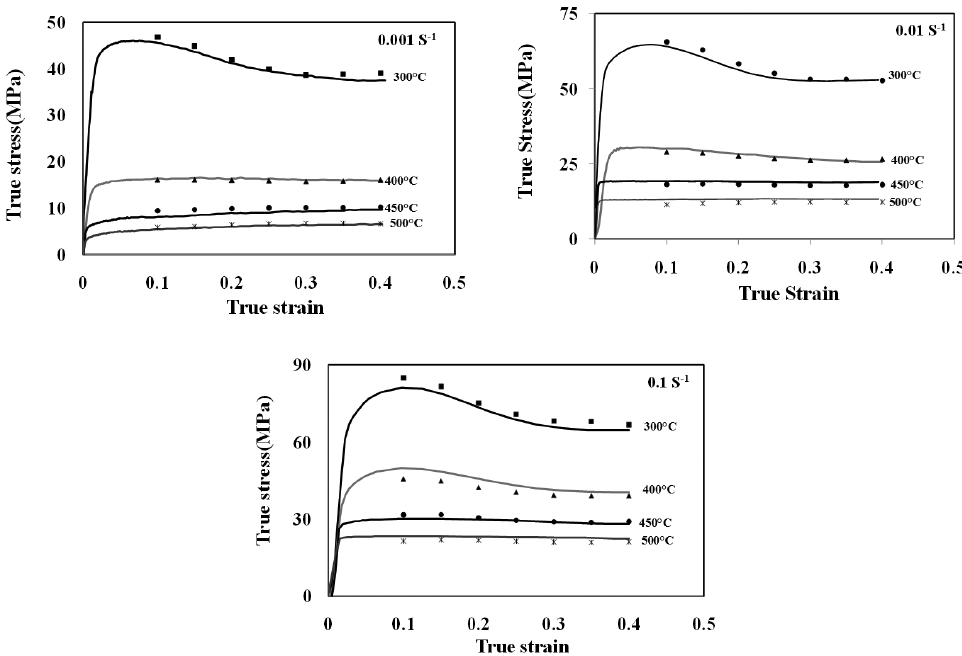
Figure 6. Comparison between the experimental and predicted flow stress at different strain rate for Rolled initial